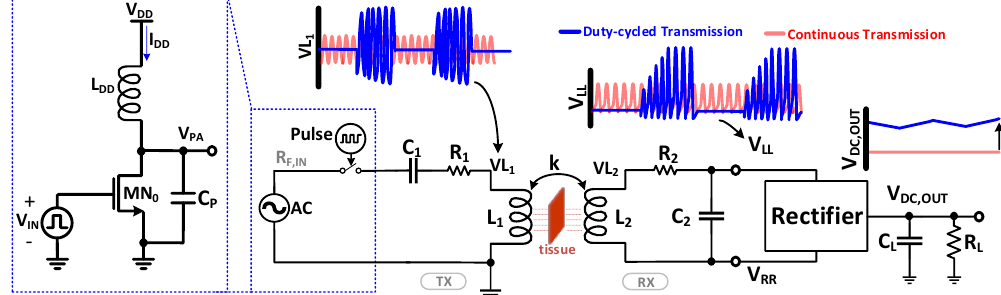
Figure 1. Circuit diagram of the general wireless power transmission (WPT) system with waveforms of major voltage nodes for the conventional continuous power transmission (in red) and the proposed duty-cycled power transmission (in blue). Inset: Implementation scenario with a class-E amplifier for the input voltage